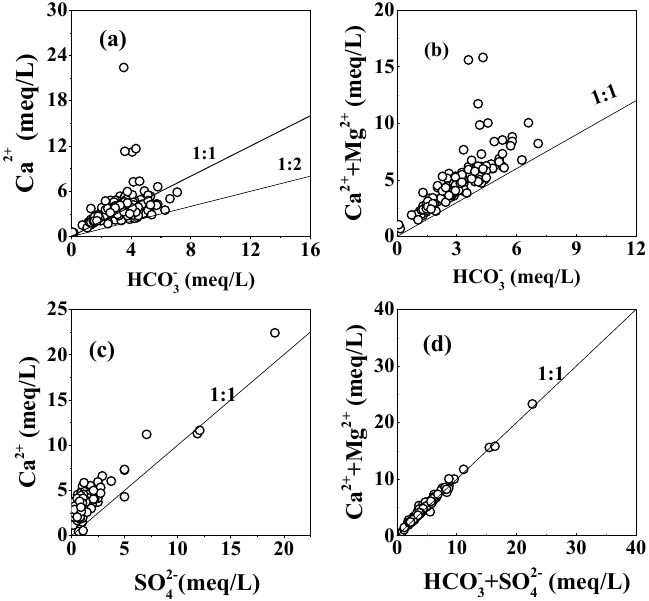
Figure 6. Relationships among major ions in groundwater samples. ( a ) Ca 2+ versus HCO 3 − , ( b ) (Ca 2+ + Mg 2+ ) versus HCO 3 − , ( c ) Ca 2+ versus SO 42 − , ( d ) (Ca 2+ + Mg 2+ ) versus (HCO 3 − + SO 42 −